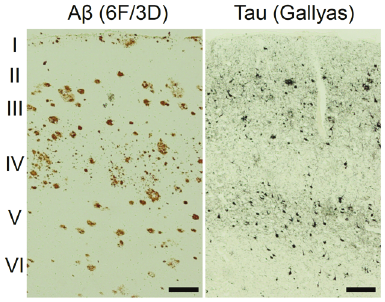
Figure 2. Different distribution of amyloid pathology and neurofibrillary pathology stained with anti-A β (6F/3D) antibody and Gallyas silver staining, respectively. Scale bar: 200 µ